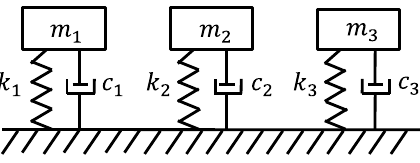
Figure 15. Model of a human body under vertical vibration [46].